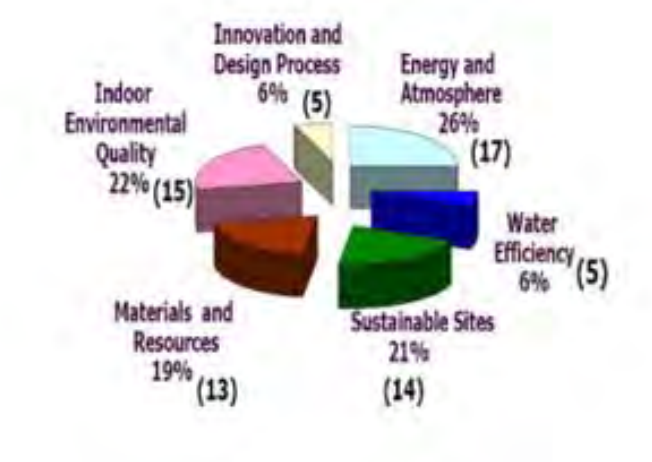
Figure 3. LEEDcategories as % of total points